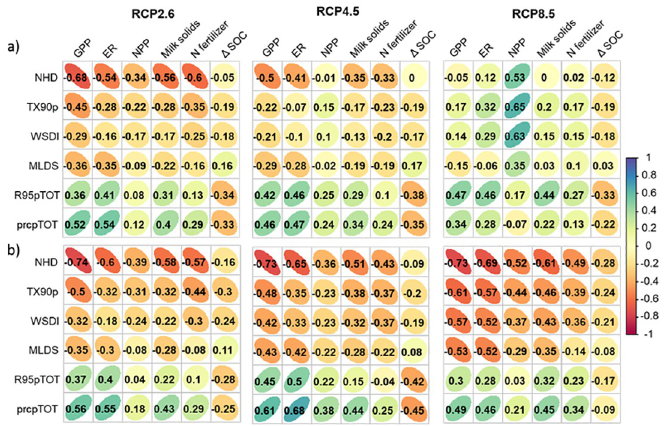
Fig 7. Correlation matrixes between the six selected ETCCDI climate indices modelled GPP, ER, NPP, Milk solids, required N fertilizer application rates and change in SOC ( Δ SOC) under RCP 2.6, RCP 4.5 and RCP 8.5 for grazed pastures with increasing (a) and constant (b) CO 2 concentrations. Numbers give the correlation coefficients and colors indicate correlation levels, going from red for negative to blue for positive correlations.